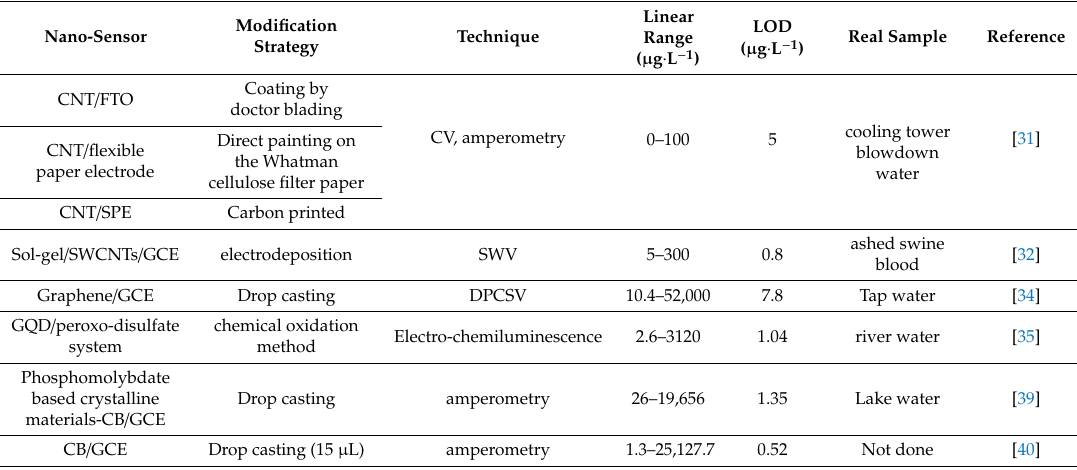
Table 1. Summary of the electroanalytical data of reported carbon nanomaterials based-electrodes for hexavalent chromium monitoring in several real